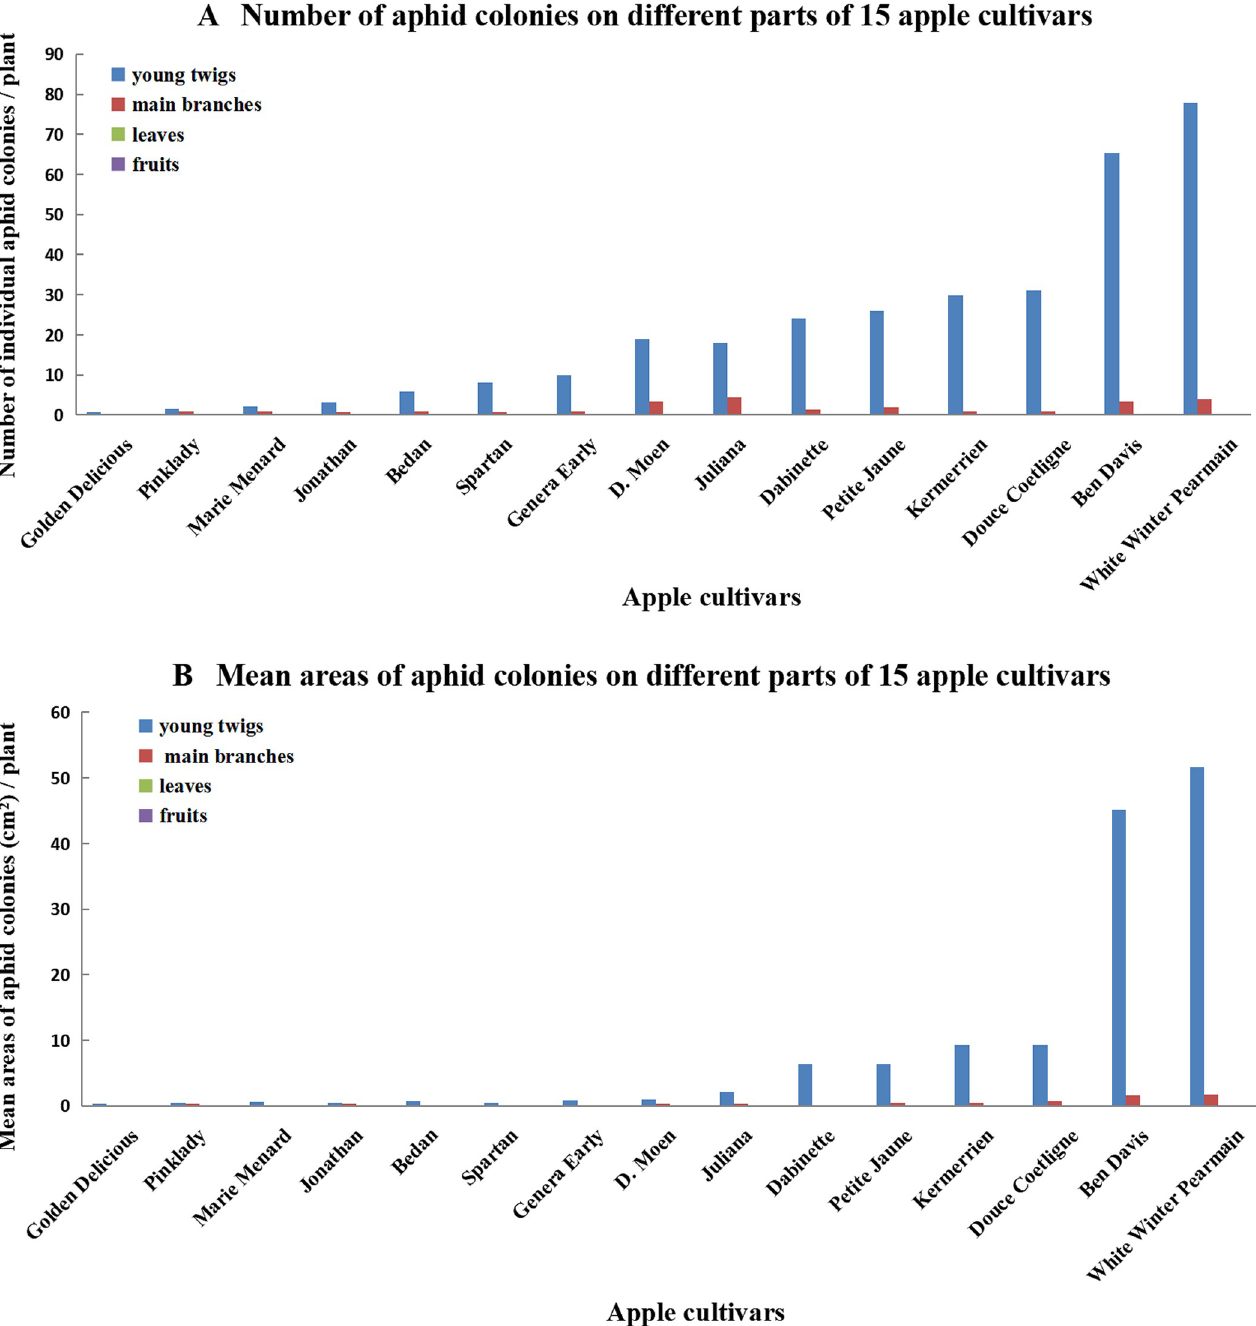
Fig 2. (A) Numbers and (B) area (cm 2 ) of aphid colonies per part on various plant parts on 15 apple varieties, in an apple orchard in Qingdao, Shandong Province, China, in June 20, 2010. https://doi.org/10.1371/journal.pone.0256641.g002 PLOS ONE | https://doi.org/10.1371/journal.pone.0256641 August 24,